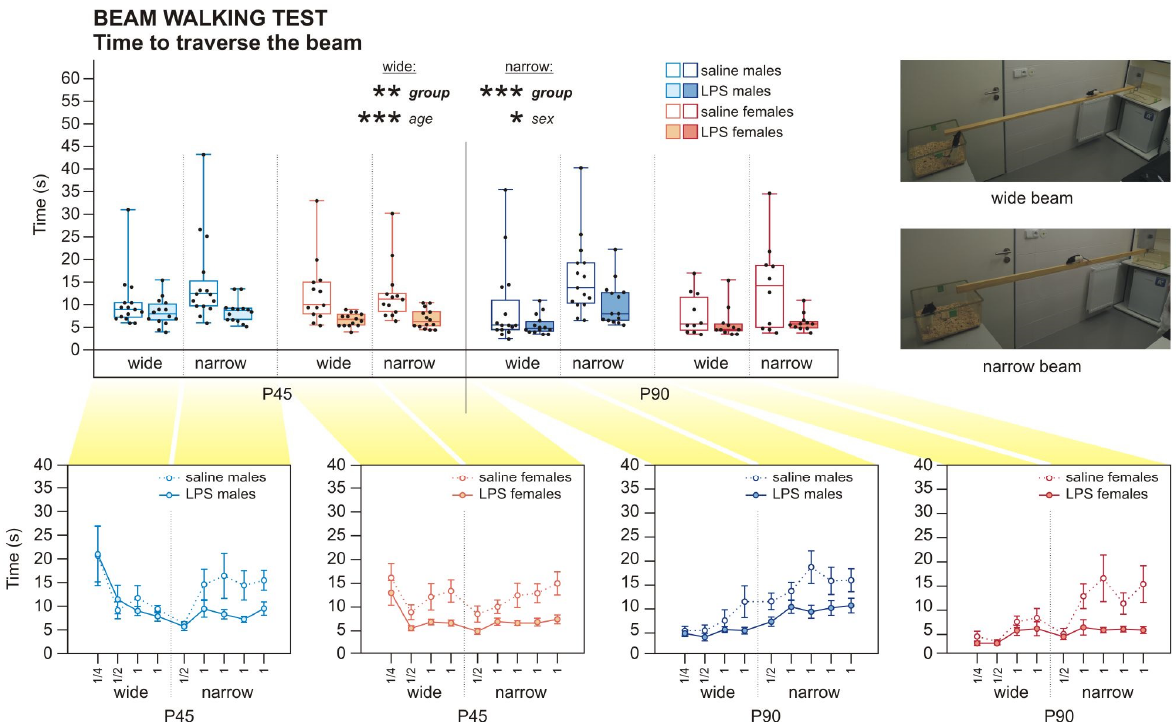
Figure 5. The beam walking test in P45 and P90 rats. LPS-exposed rats of both sexes spent less time by crossing the wide or narrow beam compared to controls at both ages, according to 3wANOVA-RM. Males took more time to cross the narrow beam than females. Adult rats spent less time traversing the wide beam than adolescent rats. The upper panel show data averaged only for whole-beam crossings. The boxplots show median, first and third quartile, and minimum and maximum values; the dots show individual values. In the x axes of the lower panels, the numbers “1/4” and ”1/2” mean training phase (0.5 or 1 m, respectively, of the beam) and ”1” means the test phase (the whole 2-m long beam). The values shown in the lower panels indicate means ± S.E.M. * p < 0.05, ** p < 0.01, *** p < 0.001.